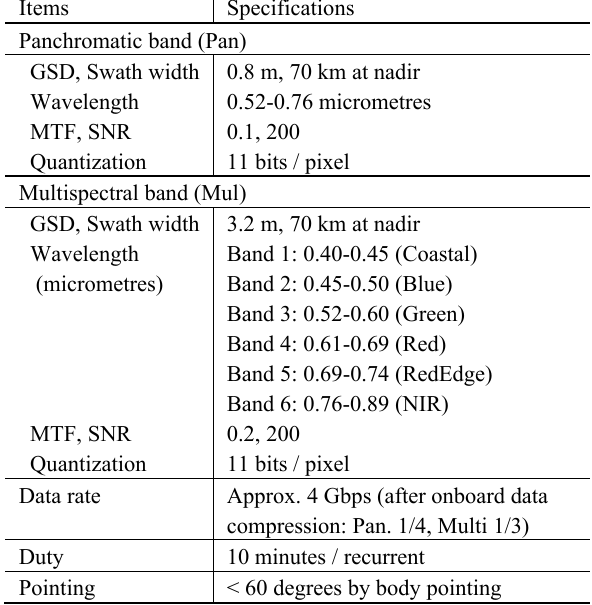
Table 2. Major specification of WISH instrument